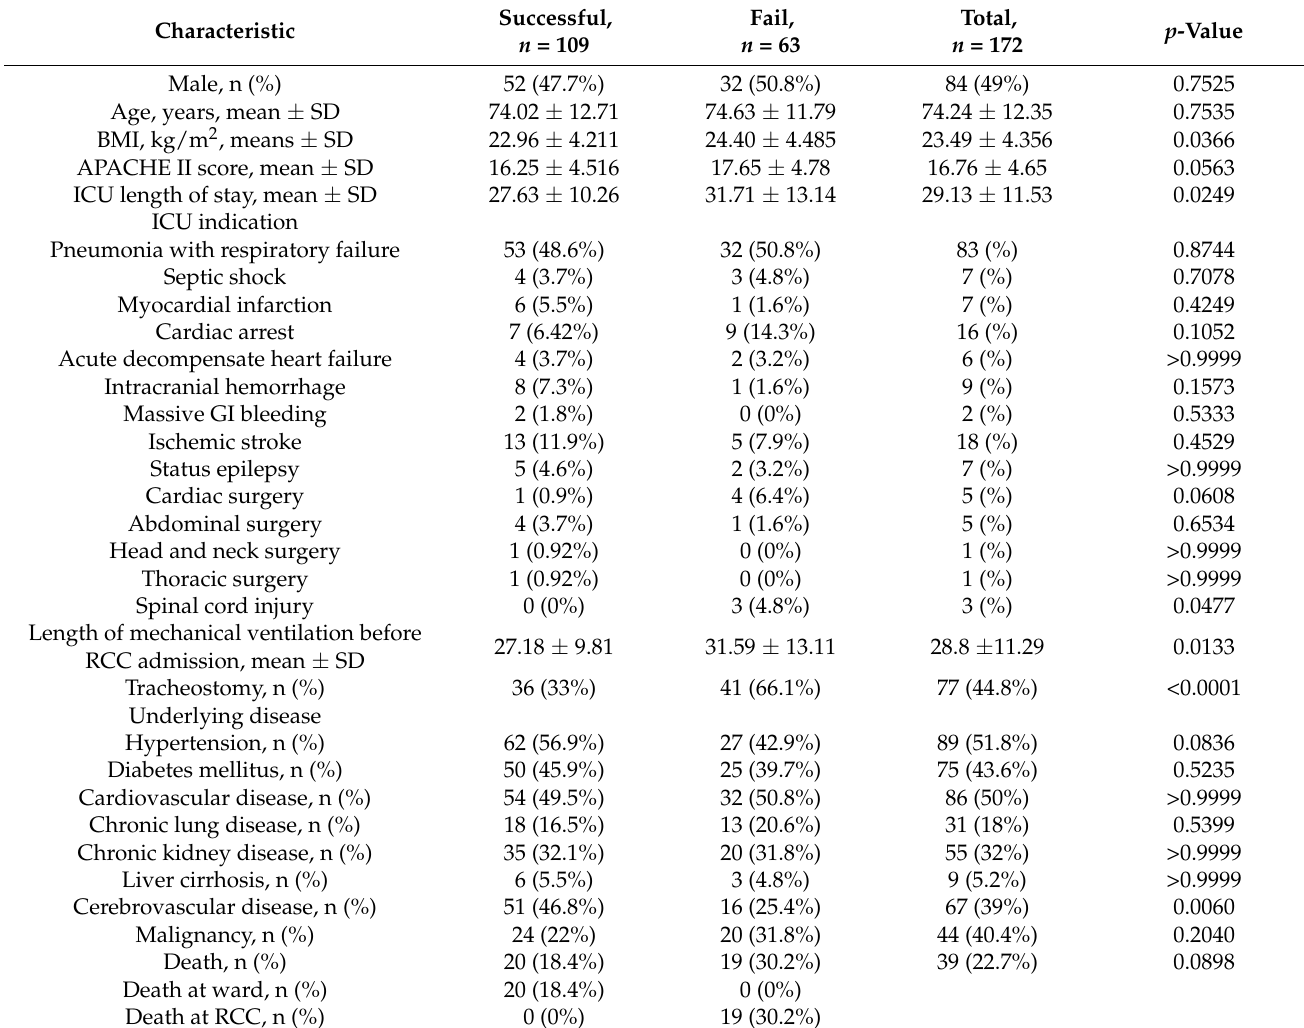
Figure 1. Flowchart of the study design. Table 1. Clinical Characteristics of patients with PMV.